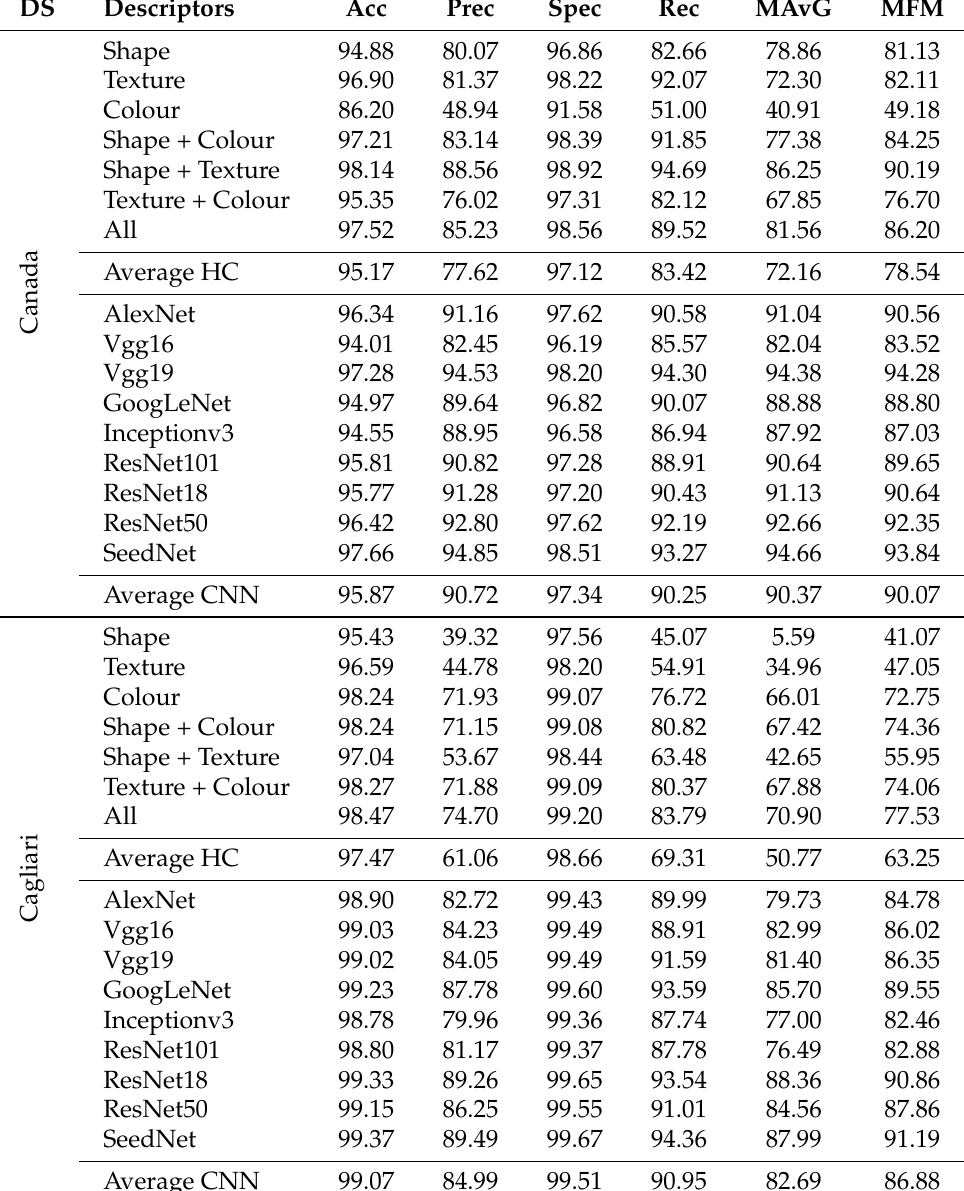
Table A1. Performance results obtained using HC descriptors and deep features with kNN classifier on Canada and Cagliari data sets. KNN were trained with k = 6 and cityblock as distance. DS indicates the data